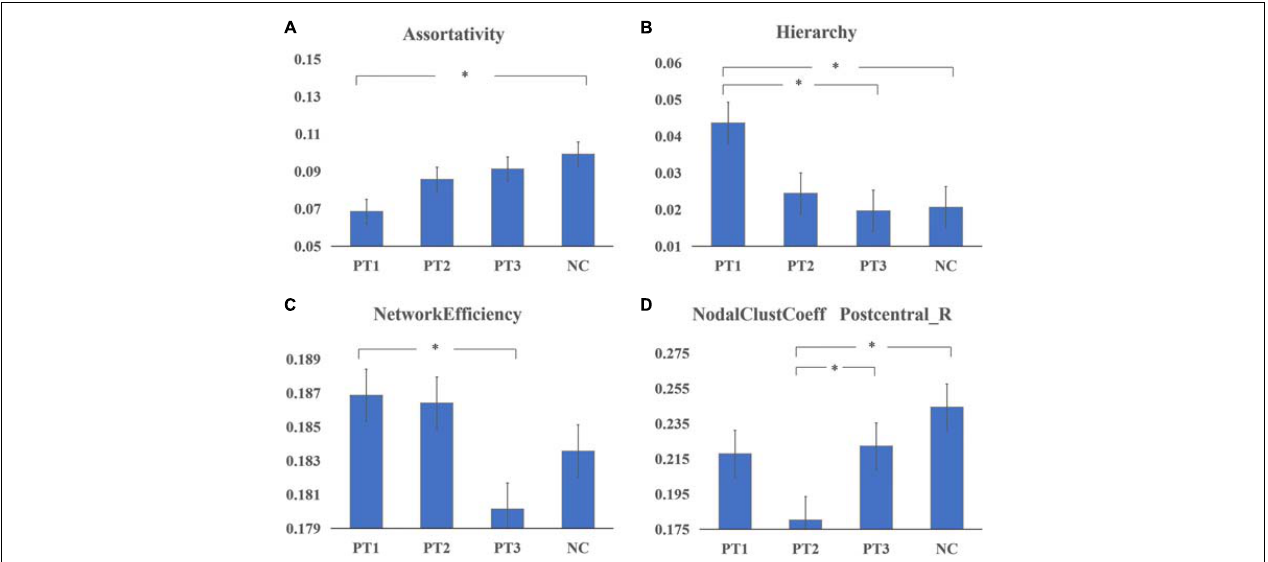
FIGURE 1 | Global parametders (A–C) and nodal parameters (D) of the static brain functional network in patients with NPC in the 0–6 months post-RT (PT1) group, > 6 to ≤ 12 months post-RT (PT2) group, and > 12 months post-RT (PT3) group vs. normal controls (NCs). (A) Assortativity was significantly smaller in the PT1 group than in the NC group ( P = 0.011). (B) Hierarchy values were significantly larger in the PT1 group than in the PT3 and NC groups ( P = 0.048 and P = 0.039). (C) Network efficiency was significantly greater in the PT1 group than in the PT3 group ( P = 0.003). (D) The nodal clustering coefficient of Postcentral_R in the PT2 group was significantly smaller than that in the PT3 and NC groups ( P = 0.023 and P = 0.000). *Means that the difference is statistically significant after multiple comparisons.